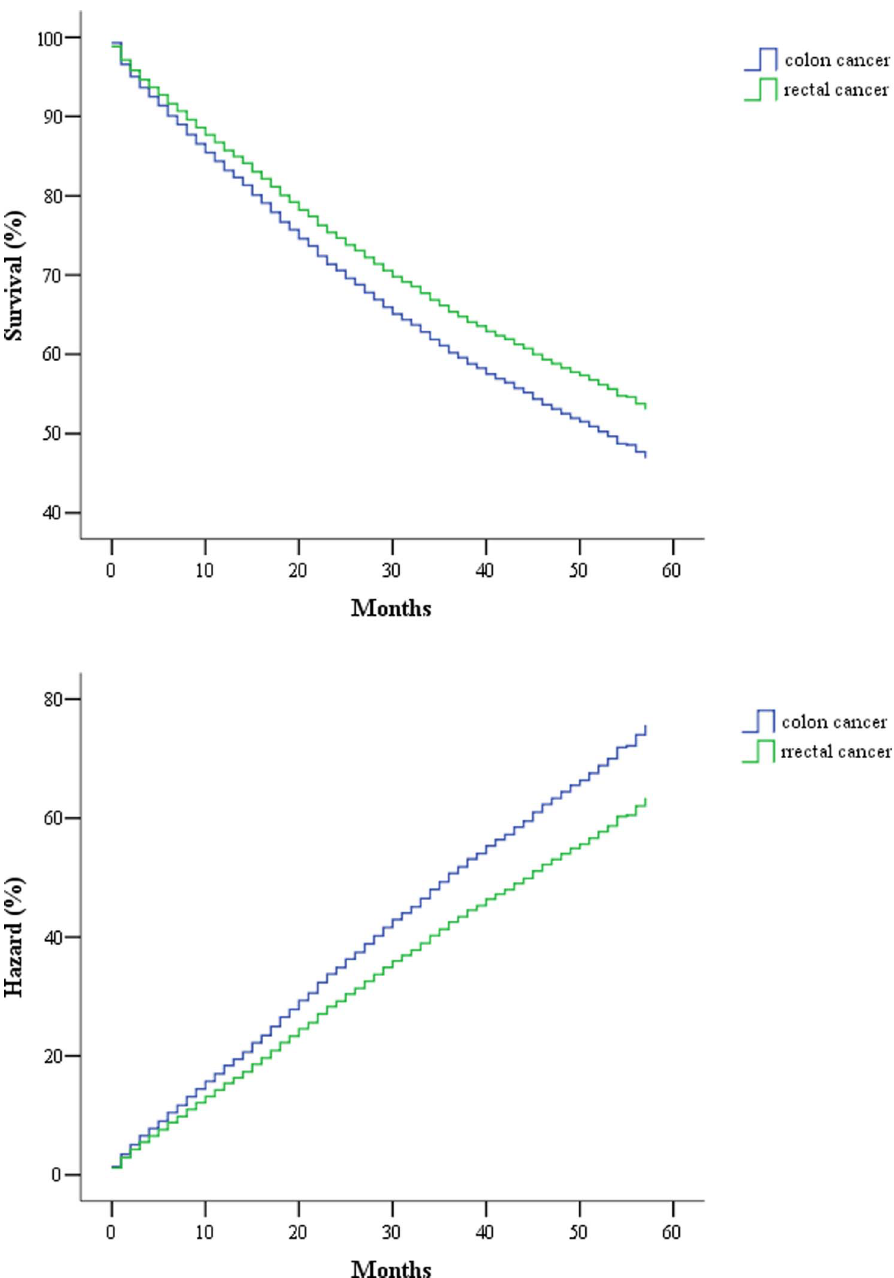
Figure 6. Survival and cumulative hazard in Cox regression model of stage IIIC colon and rectal cancer patients.